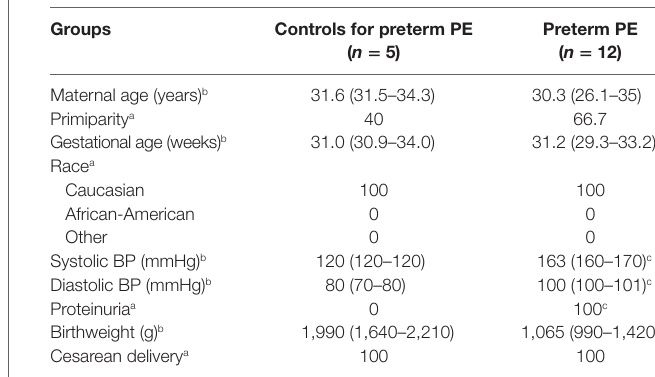
TaBle 1 | Demographics of Hungarian women included in the placental microarray